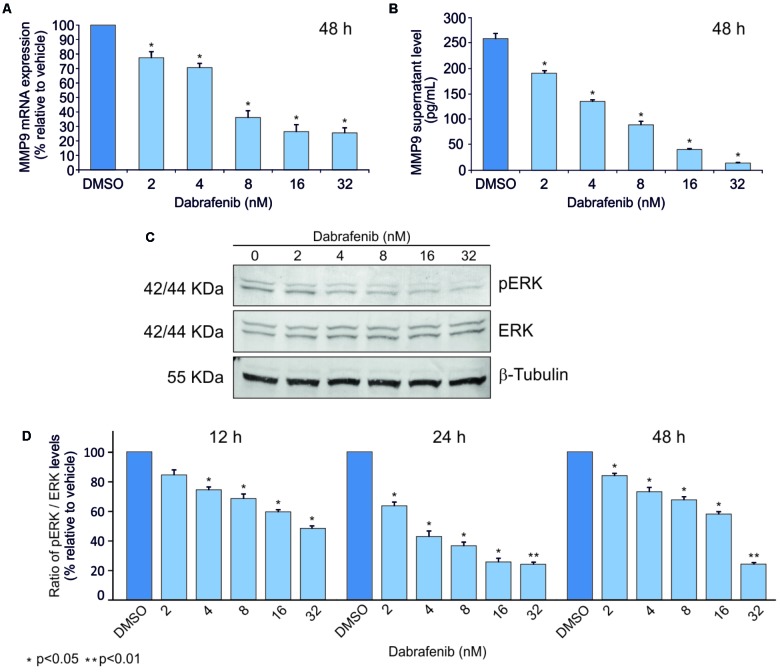
Dabrafenib treatment of A2058 cell line. A2058 cell line was treated with different doses of dabrafenib (2, 4, 8, 16, and 32 nM) for 12, 24, and 48 h. Real-Time PCR (A) and ELISA assay (B) were performed to evaluate MMP-9 expression levels of A2058 after 48 h of treatment. pERK and total ERK protein levels in A2058 cells treated with dabrafenib at 12, 24, 48 h were evaluated by Western blot (C,D). The statistical significance of the two-tailed Student’s t-test was referred to the control. ∗p < 0.05; ∗∗p < 0.01.